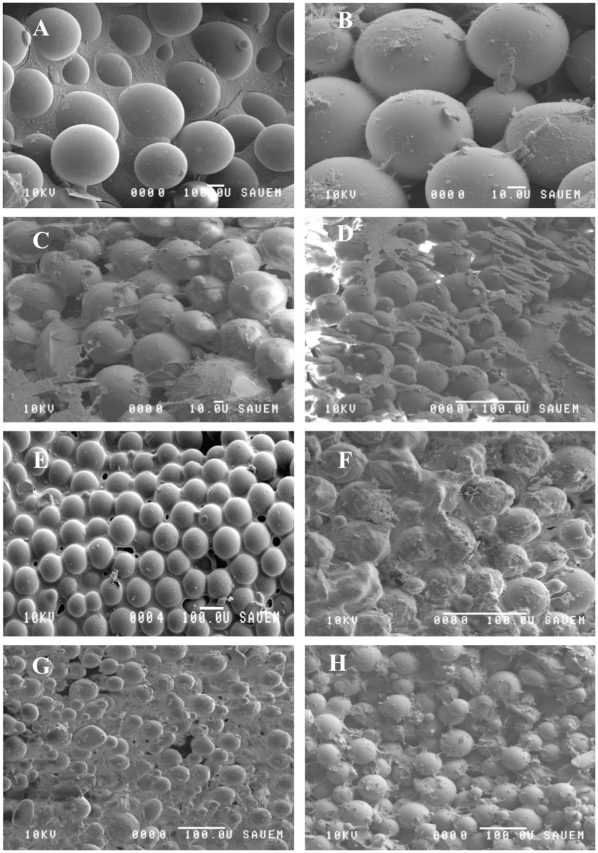
Low-temperature scanning electron microscopy (LTSEM) images of the biofilms:A B: controls (negative and positive, higher magnification) at day 1 C D: T 2 and T5 at day 1 E F: controls (negative and positive, lower magnification) at day 7 G H: T2 and T5 at day 7. A/E: Water frozen around the clean glass beads of the control without biofilm. In the presence of bacteria (B – D; F – H), a matrix of EPS is visible, heavily covering the glass beads and permeating the intermediate space. However, at day 7, the biofilm exposed to higher TCS concentrations (H) showed a visibly less dense EPS matrix as compared to the low TCS concentration treatment (F).